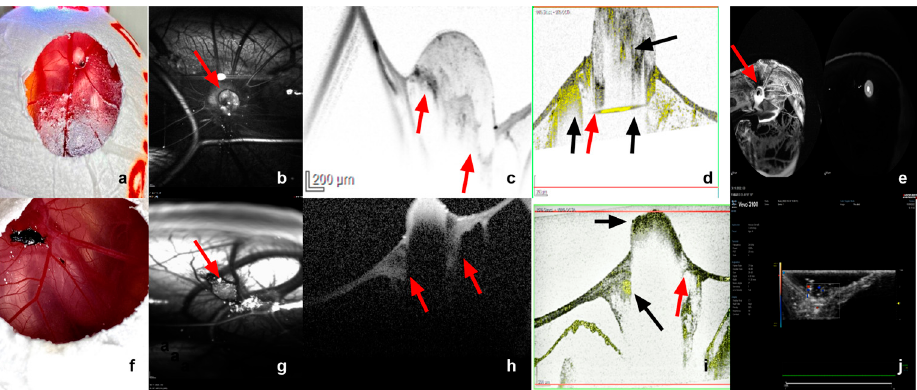
Figure 8. Infrared imaging, OCT and OCT–angiography, fluorescein angiography, as well as color doppler sonography as monitoring tools for tumor growth and vascularization. ( a – e ) Tumor graft implanted with Matrigel alone on ED18, ( f – j ) tumor graft implanted without Matrigel on ED18. ( b , g ) Visualization of the tumor (arrow) as well as the detailed vascular supply in the proximity and around the base of the tumor via infrared imaging, presentation of the typical vascular star around the implanted graft. ( c , h ) Monitoring of the tumor size and invasion of the tumor into and under the CAM membrane as a sign of growth and successful implantation with optical coherence tomography. ( d , i ) Optical coherence angiography for the evaluation of the microvasculature inside the tumor and, therefore, of the viability, visualization of an intense vascular signal around the graft and under its base, as already shown in the infrared imaging, and invasion and growth of the tumor into the CAM; red arrow indicates the sign of invasion into the CAM and black arrows indicate vascular supply in the tumor tip, base, and around the graft. ( e ) A precise visualization of the vascular plexus of the complete CAM, as well as around the tumor (arrow) after intravascular injection of 50 µg fluorescein in a supplying vessel of the tumor. ( j ) Color doppler ultrasound as a further alternative non-invasive instrument to control the vascularization inside the grafts and their viability.